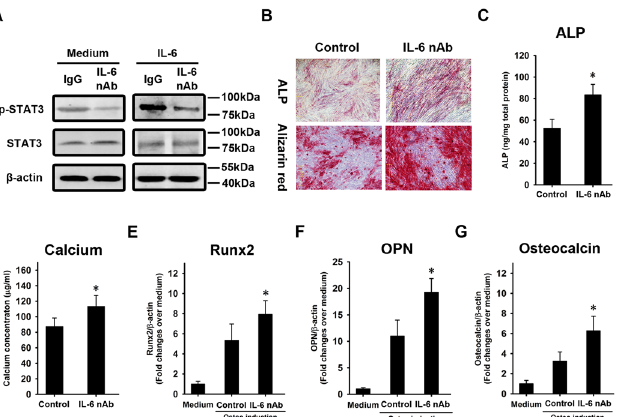
Fig 4. An IL-6 neutralizing antibody enhances the osteogenesis of osteoporotic BMSCs. Osteoporotic BMSCs, with and without IL-6 treatment, were treated by an IL-6 neutralizing antibody. IgG was used as a control. STAT3 phosphorylation was analyzed by western blot (A) . Alkaline phosphatase (ALP) and Alizarin Red staining were performed at weeks 1 and 3, respectively (B) . The quantification of ALP (C) and measurement of calcium concentration (D) were performed. At week 2, total RNA was extracted and subjected to quantitative RT-PCR analysis using primers for Runx2 (E) , OPN (F), and OC (G) . β -actin was used as an internal control. The results are expressed as the fold-change relative to BMSCs without induction. The data are shown as the mean ± SD. * : p < 0.05, IL-6 nAb vs . control.